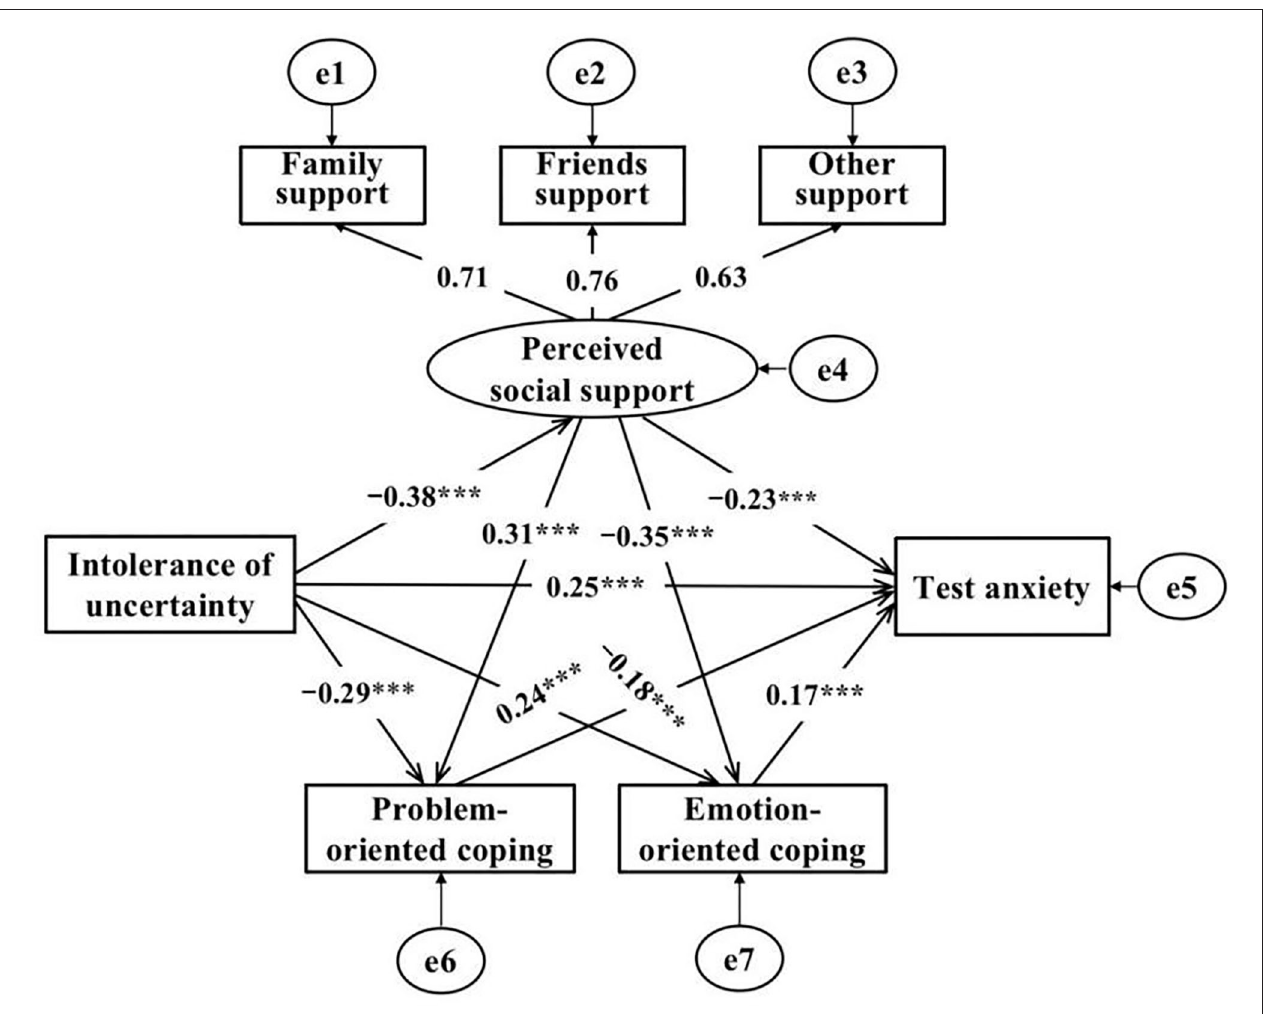
FIGURE 2 | The mediating model of perceived social support, coping styles between IU and test anxiety.